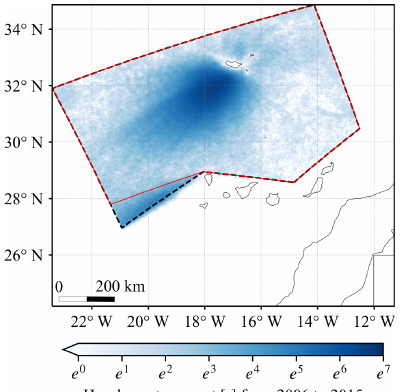
Figure 14. Hourly vortex count at each grid cell in CRS1 from 2006 to 2015 (in total 87648h, e 7 ≈ 1097). It shows the results when we used the dashed black polygon to restrict the region where the cen- tre of vortices shed from Madeira Island can appear as described in Sect. 2.4. For each grid cell at each hour, we counted the vor- tex number as one if an identified vortex covers this grid cell. The exponential scale was used to account for the unevenly distributed frequency in vortices. The geographic map is from Natural